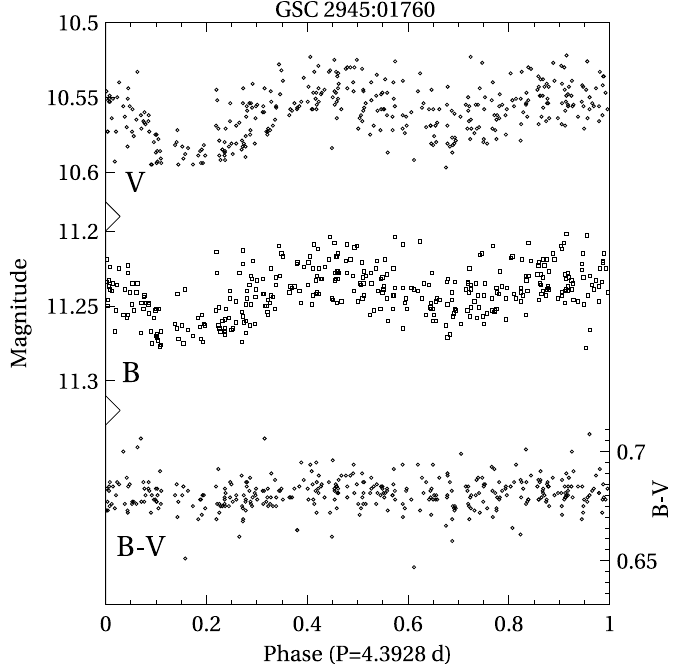
Figure 2. B , V , and ( B - V ) light curves of GSC 2945:01760 phased with a period of 4.3928 days and arbitrary